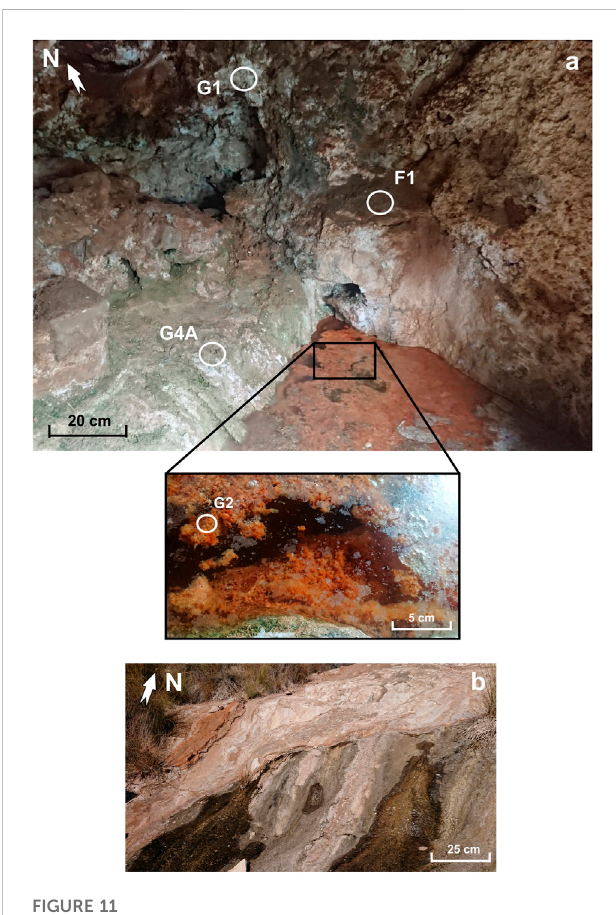
FIGURE 11 (A) Water spring in cave associated with the north branch of the pop-up structure. G1, G2, G4a and F1 are samples of different materials analyzed inthiswork. Awater samplehas beentaken fromtheupwelling for geochemical analysis (sample SC see Figure 3 for location). (B) Close-up view of a water source formed on the slope of the Carraclaca pop-up structure, 150 m south of the cave. The water sample taken at this point has been analyzed for this work (sample SH, see Figure 3 for